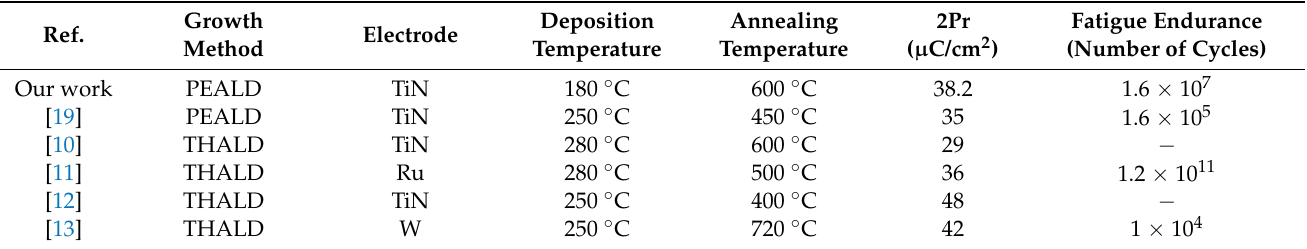
Table 3. Summary and comparison of the preparation methods and electrical properties of HZO